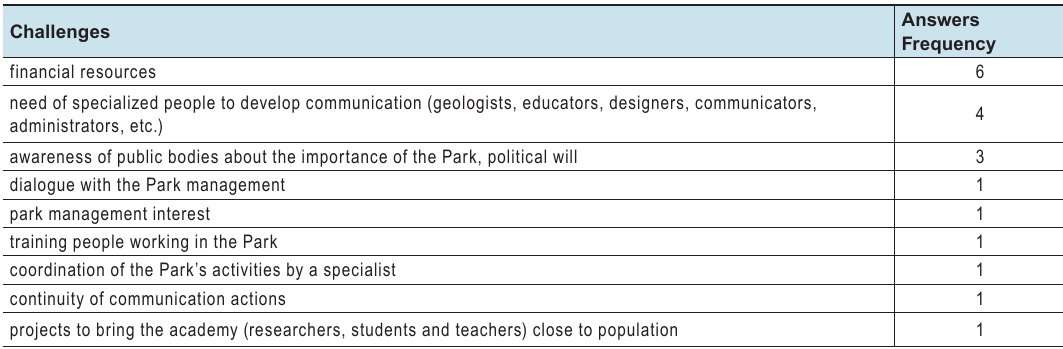
TABLE 5. Challenges of the external environment listed by the stakeholders regarding communication.